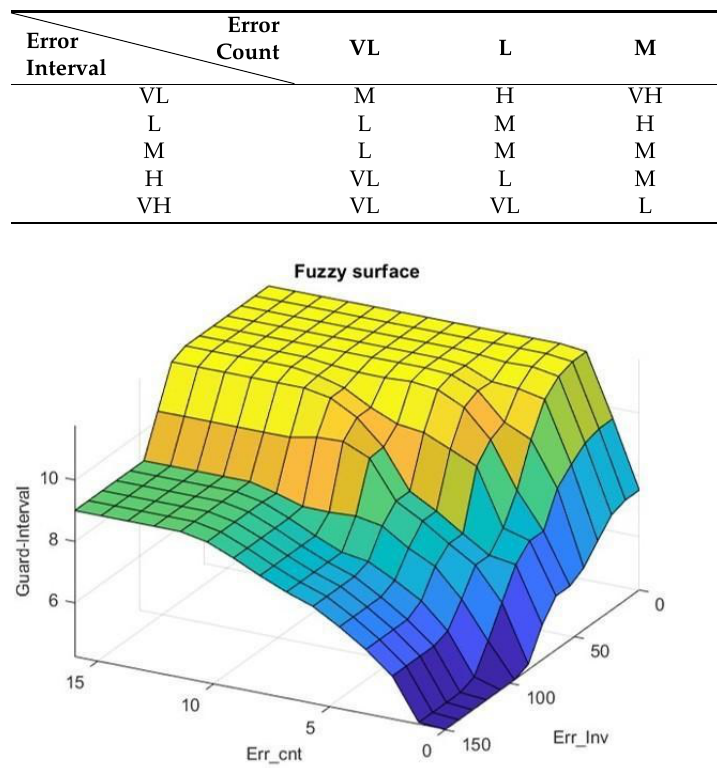
Figure 8. Relations of error count, error interval, and guard.